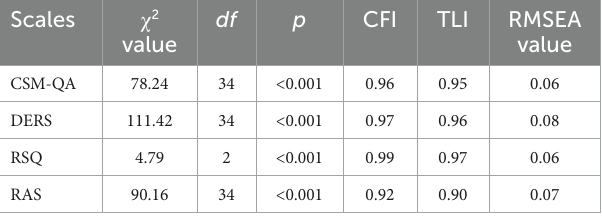
TABLE 5 Confirmatory factor analysis (psychological and social well- being, self-criticism and concentration when faced with difficult emotions, shyness, and conflict avoidance, need for independence).